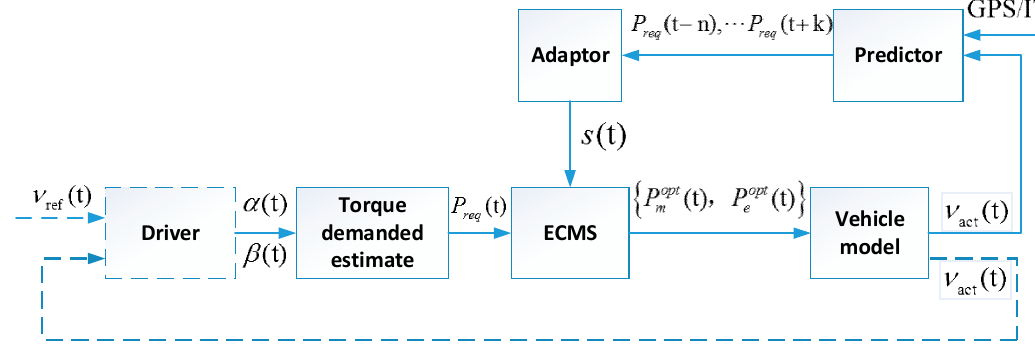
Figure 8. Structure of the adaptive equivalent consumption minimization strategy (A-ECMS). Note that s ( t ) is the equivalent factor, and α ( t ) and β ( t ) is the acceleration and deceleration pedal, respectively.